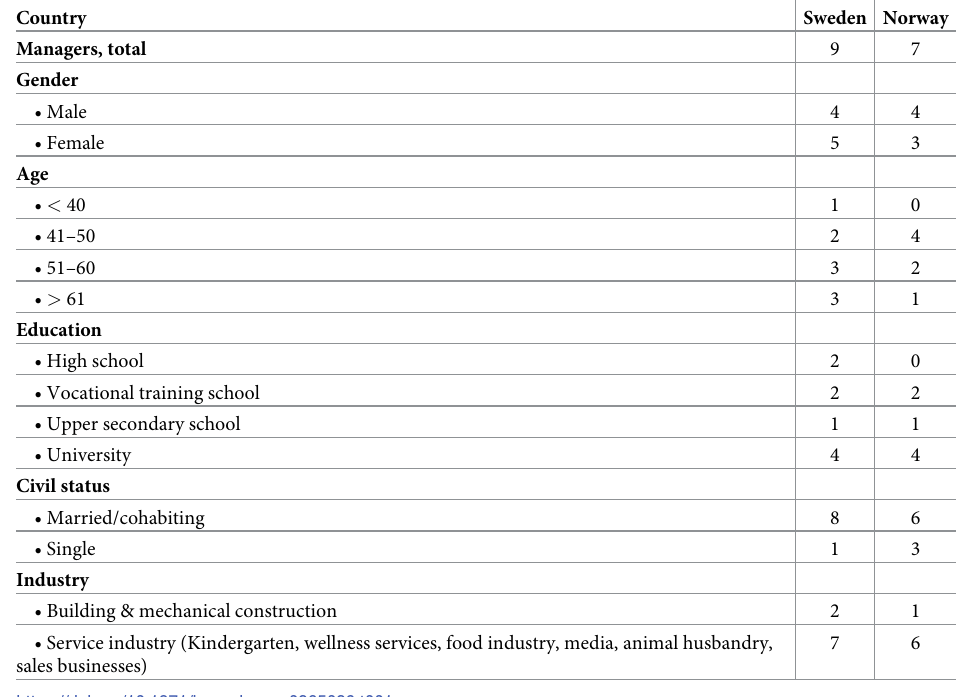
Table 1. Characteristics of the